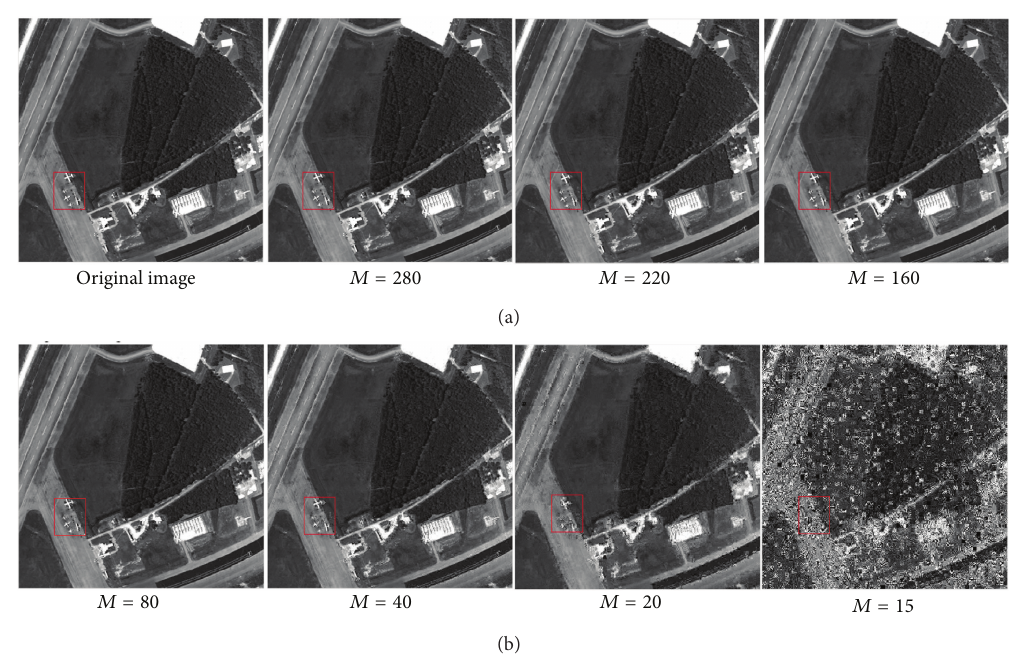
Figure 12: Reconstructed image using our method at different 𝑀 ; the size of each image is 512 × 512 .